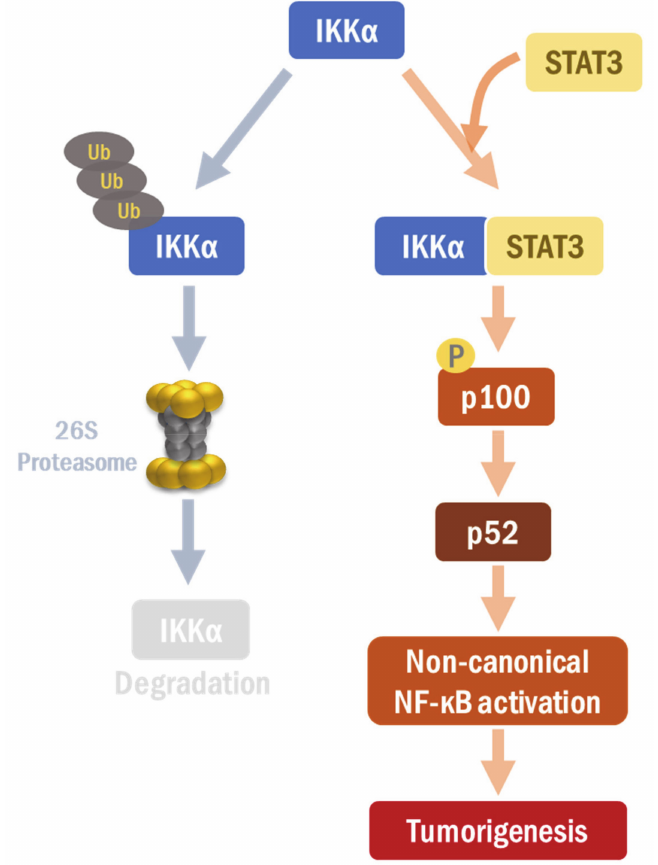
Figure 6. A proposed scheme of the interaction between STAT3 and IKK α . STAT3 directly interacts with and stabilizes IKK α , thereby regulating non-canonical NF- κ B